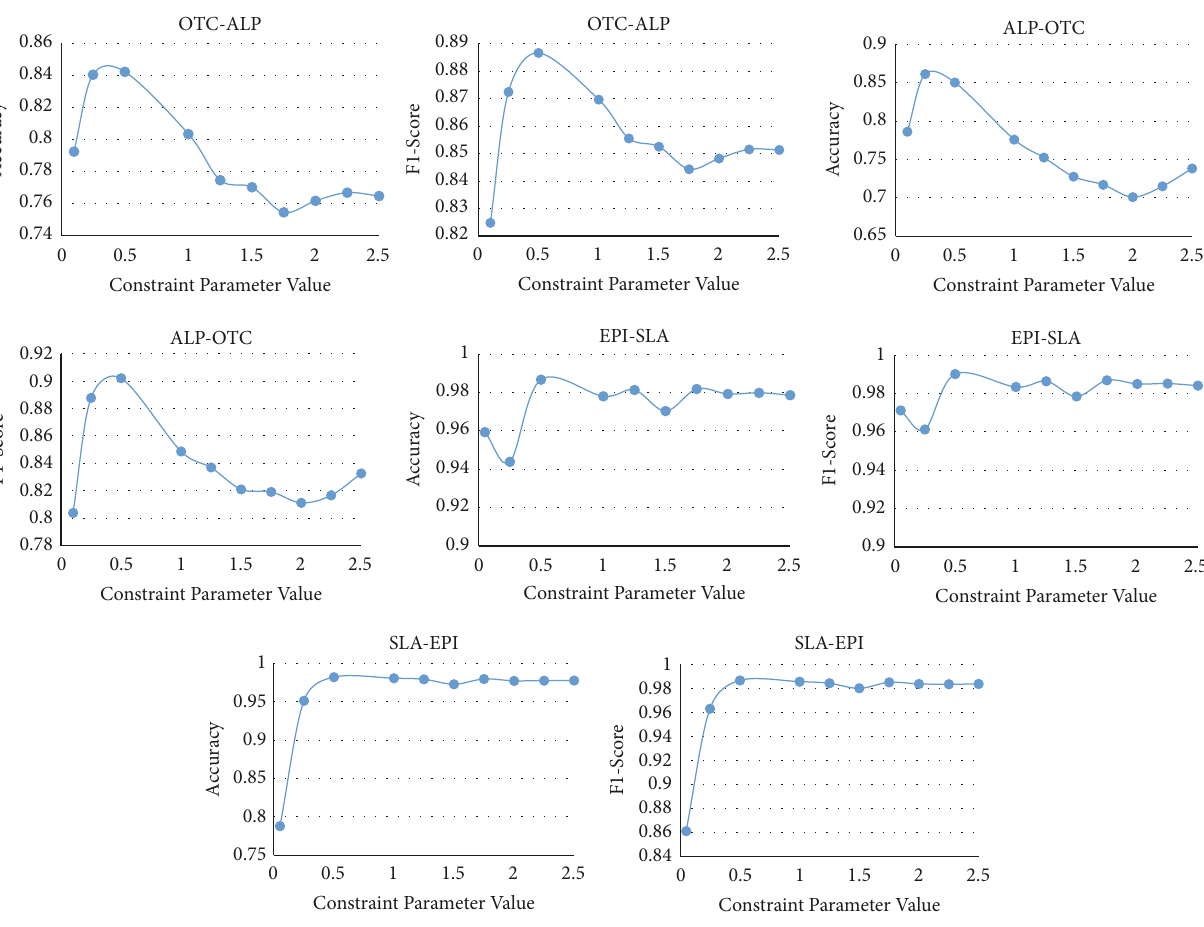
Figure 5: The influence of the constraint parameter on sign prediction